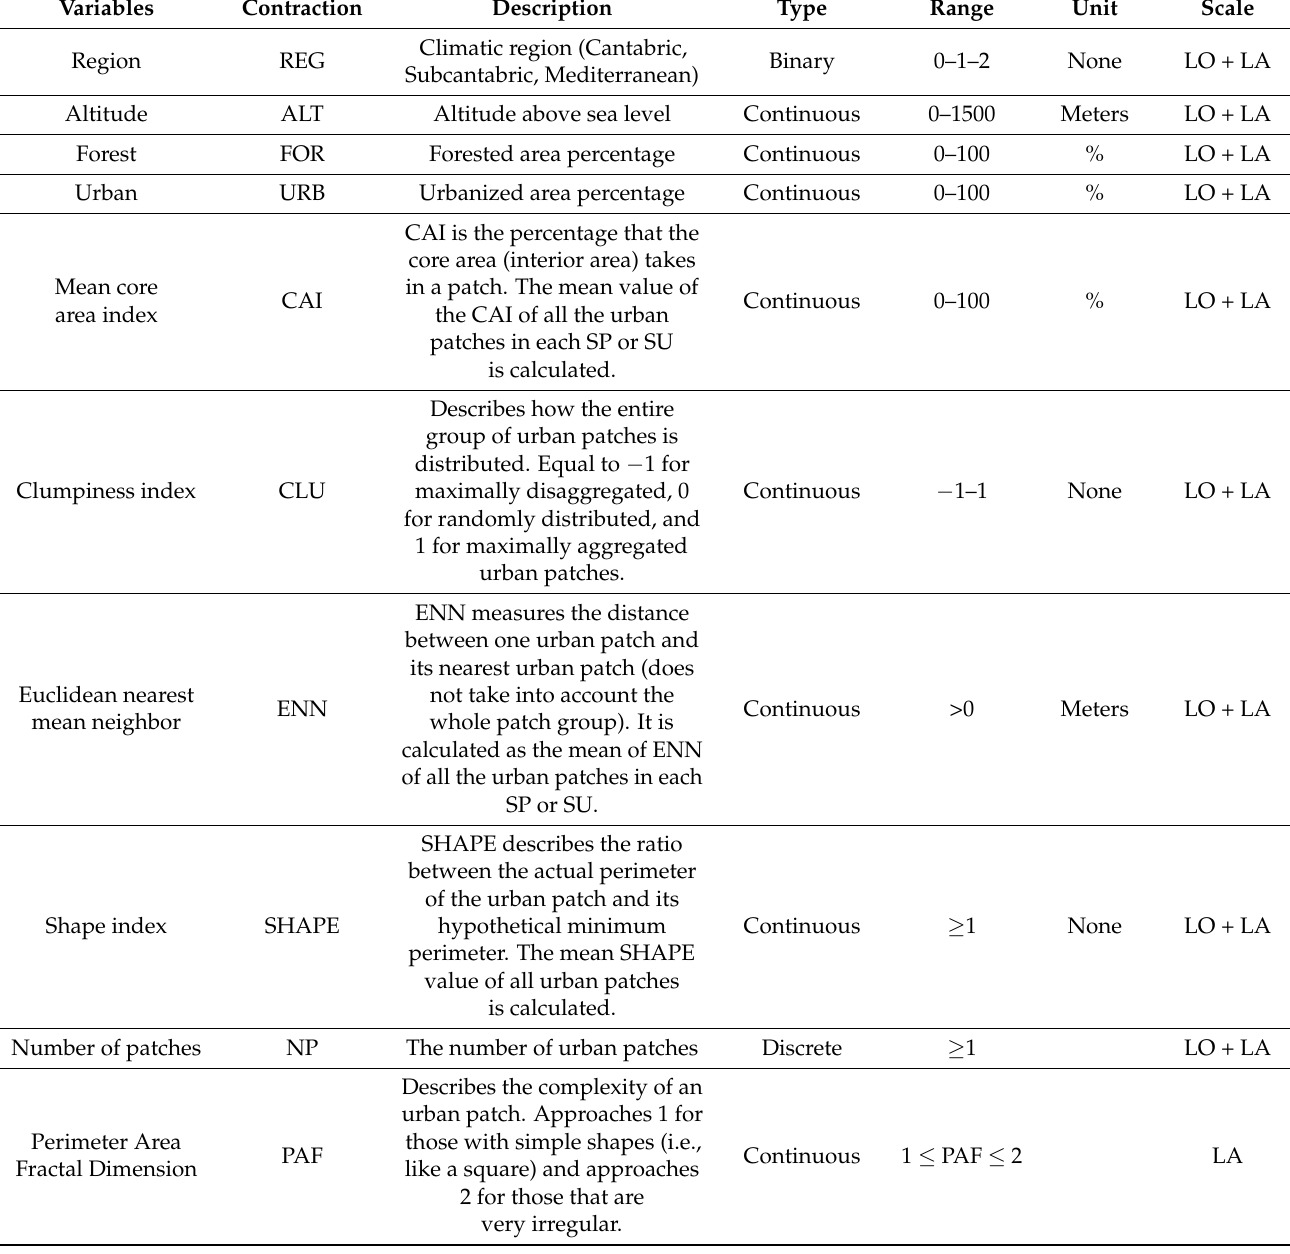
Table 2. Description of the variables used for the top-ranked models at both spatial scales, local and landscape. The “SCALE” column shows the spatial scale used for each variable in the models (LO: local and LA: landscape).